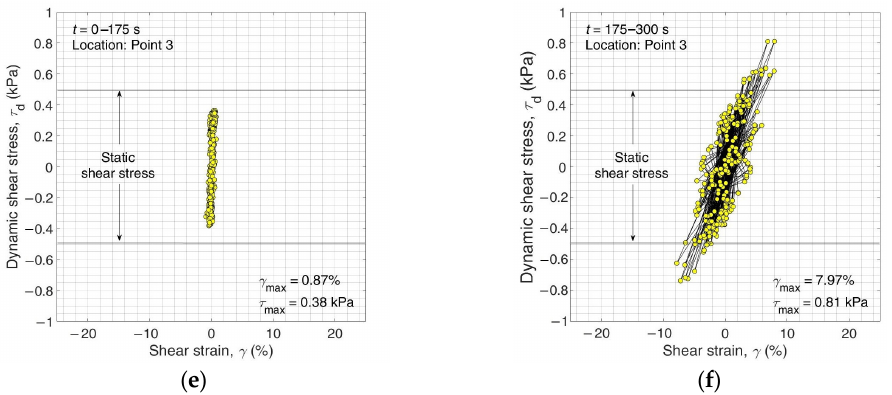
Figure 22. Shear stress-shear strain relationships: ( a ) point 1 at t = 0–175 s, ( b ) point 1 at t = 175–300 s, ( c ) point 2 at t = 0–175 s, ( d ) point 2 at t = 175–300 s, ( e ) point 3 at t = 0–175 s, and ( f ) point 3 at t = 175–300 s.